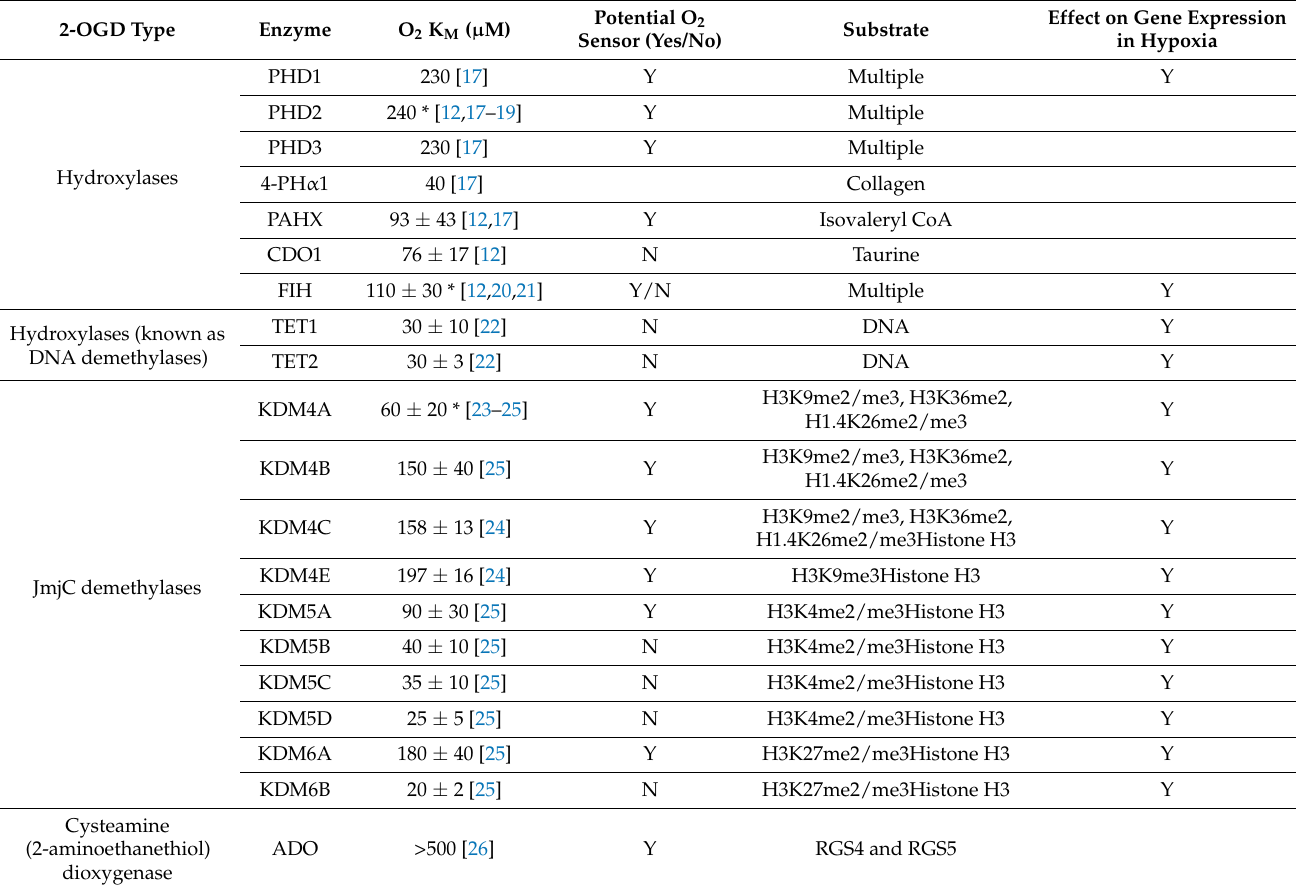
Table 1. 2-OGDs with reported affinities for oxygen from in vitro assays. The K M values for oxygen have been determined via a range of in vitro experiments. The K M obtained is affected by substrate, conditions, and technique, and therefore provides only a possible indication of oxygen sensing capability. We have assessed, from the reported K M s and cellular data, whether these 2-OGDs might act as oxygen sensors. * Median K M from multiple studies (individual values listed in Supplementary Table S1).